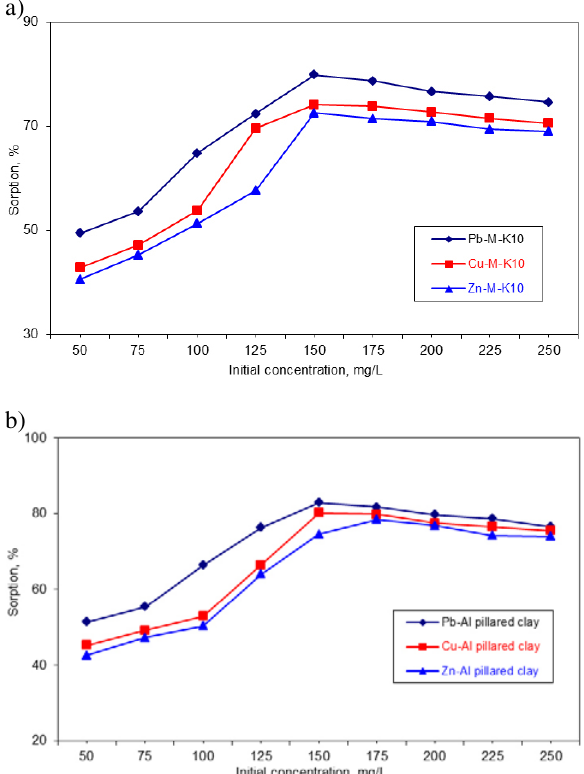
Fig. 3. Effect of initial ions concentration on adsorption of Pb 2+ , Cu 2+ and Zn 2+ on montmorillonite-K10 (a) and Al-pillared clay (b).